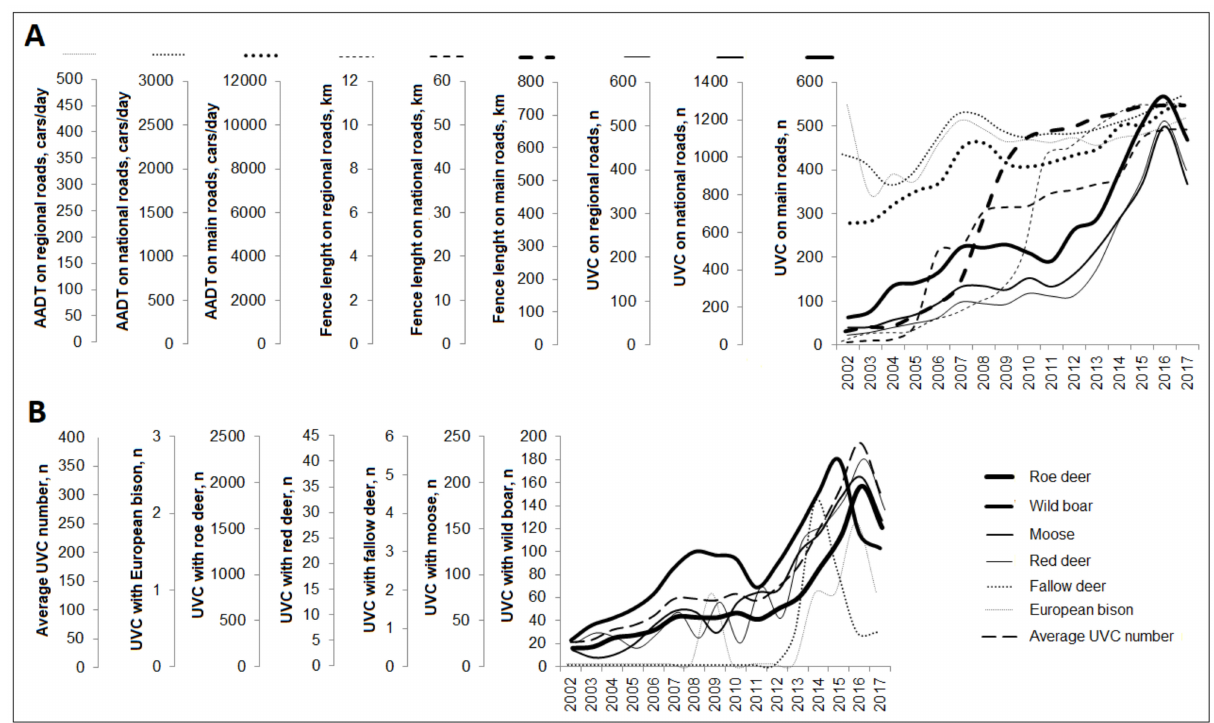
Figure 3. UVC hotspots and fenced road sections in the 2002–2017 period.